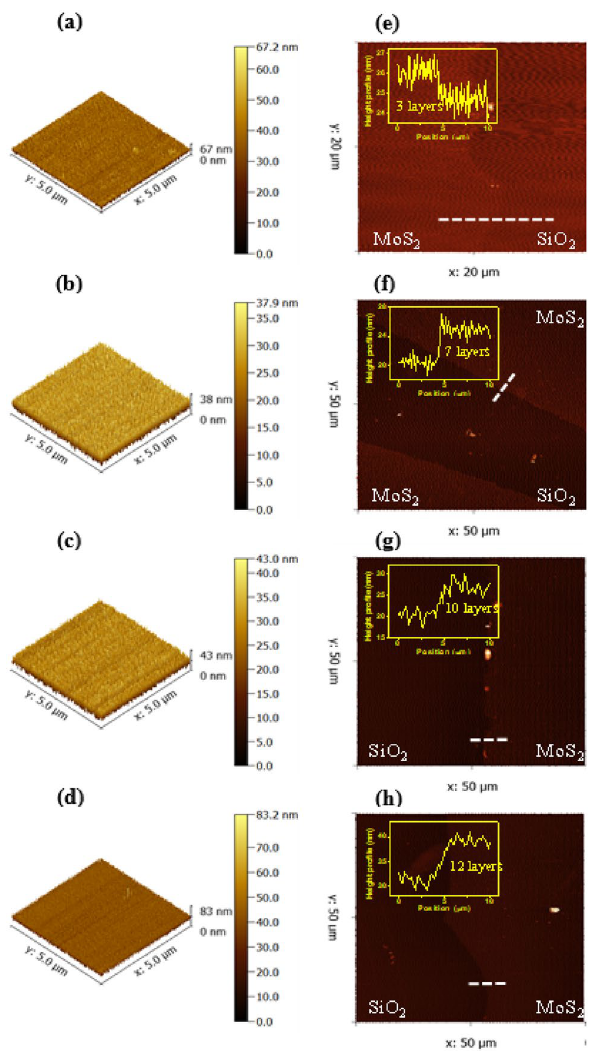
Figure 3. AFM images at surface of printed MoS 2 on SiO 2 and at the MoS 2 –SiO 2 boundary with height profile taken from the corresponding white dash line: ( a , e ) 0.025 M, ( b , f ) 0.05 M, ( c , g ) 0.075 M and ( d , h ) 0.1